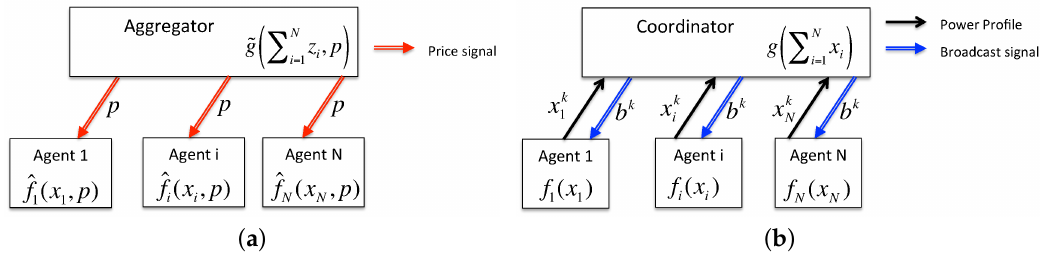
Figure 4. Management architectures. ( a ) In price-based demand response (DR) the aggregator determines the price signal and then each agent independently determines its power usage; ( b ) In coordinated energy management, the agents, with the help of a coordinator, iteratively minimize the community objective and each agent’s